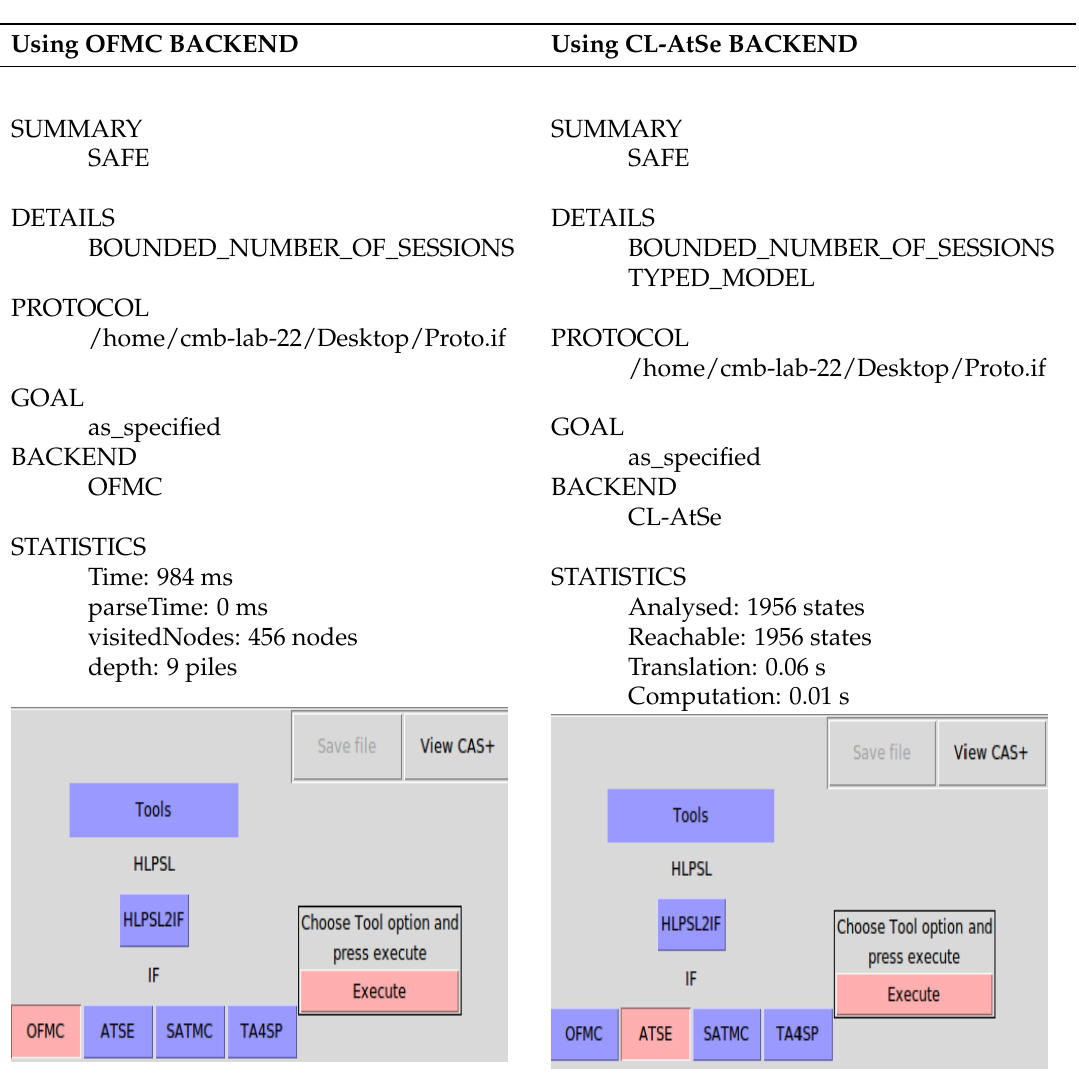
Table 20. Security verification result obtained using AVISPA